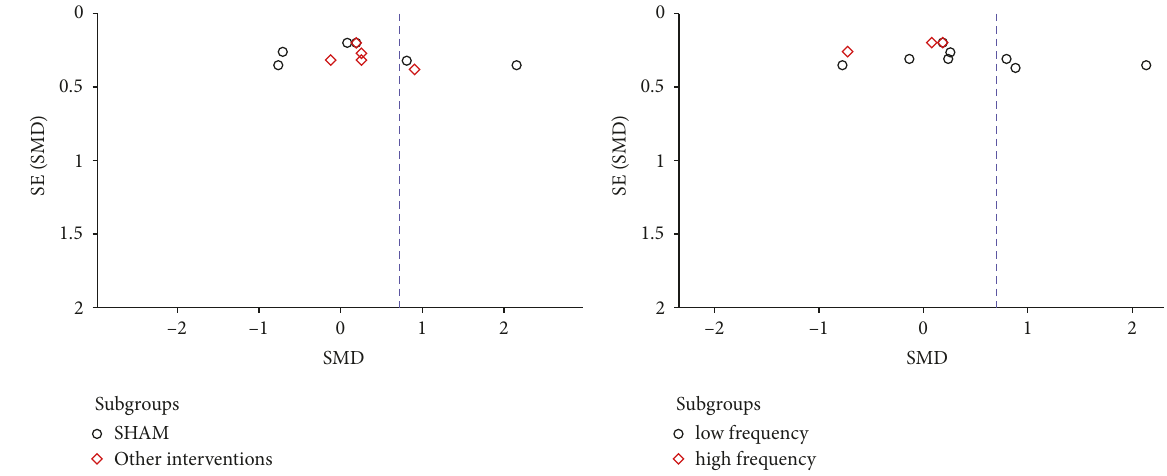
SHAM Figure 6: Funnel plot records divided by frequency and type of